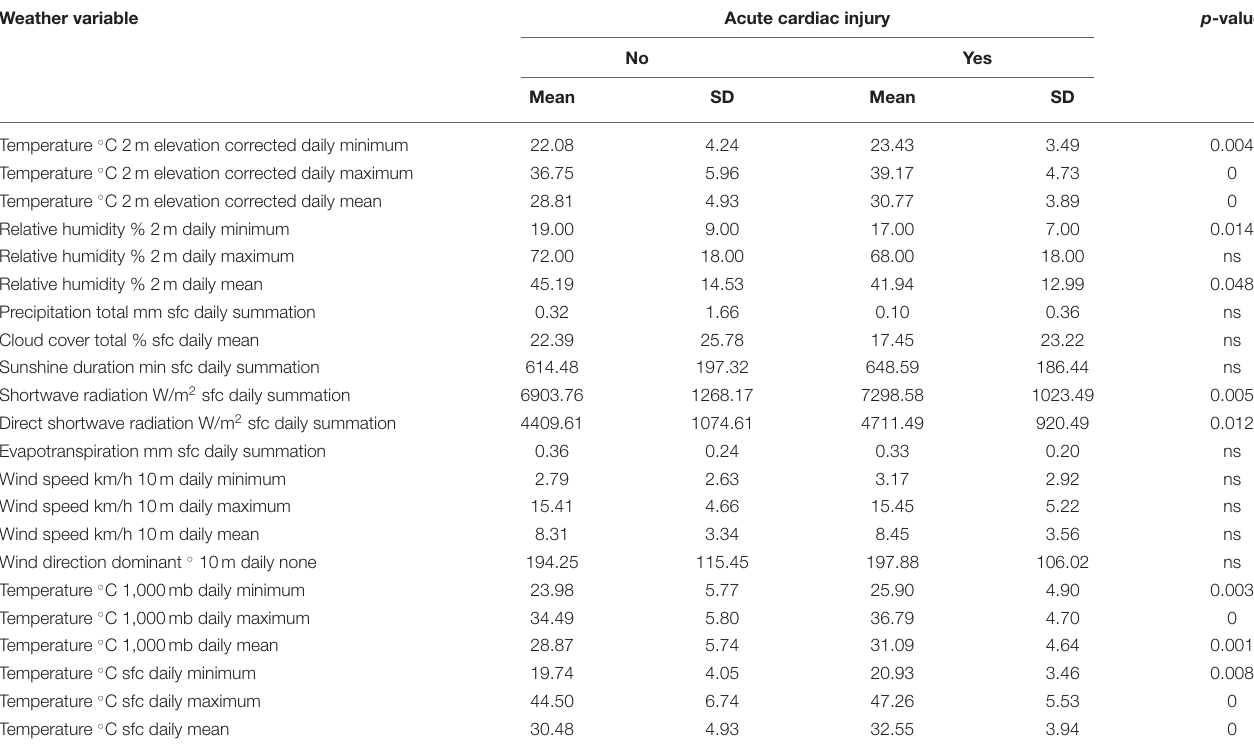
TABLE 3B | Difference in day-of-admission weather variables in Dubai City between COVID-19 patients’ clinical outcomes: Acute cardiac injury. Weather